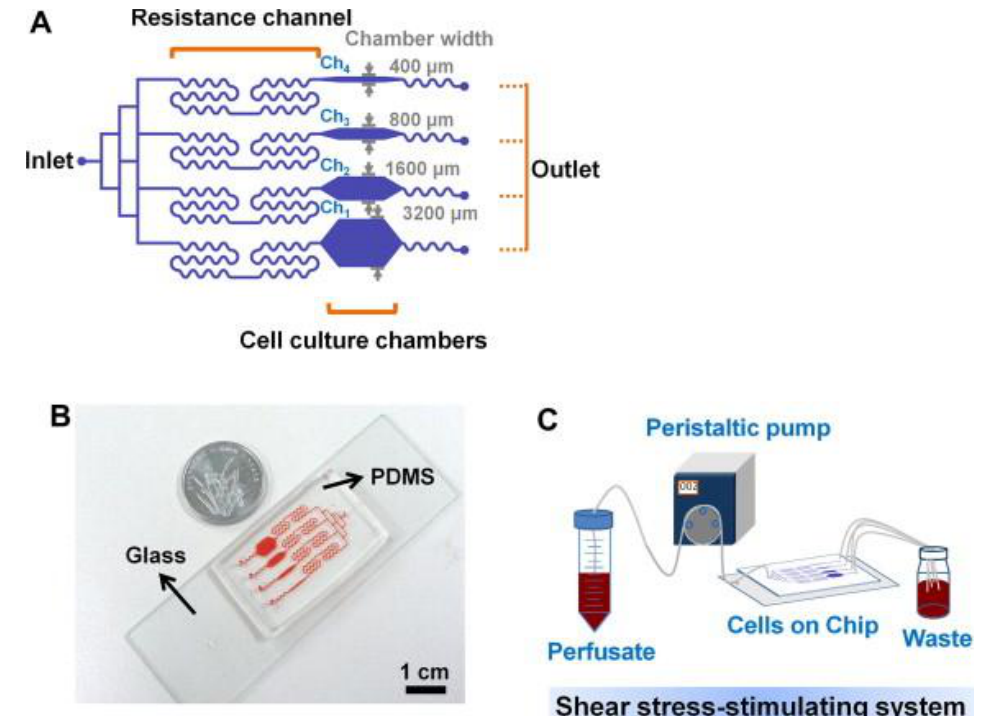
Figure 3. Multishear microfluidic device used for assessing bone cell response to fluid flow at varying shear stresses. ( A ) Flow path in microfluidic chip with resistance channels. The channel with narrow chamber width (e.g., 400 (cid:541) m) produced higher shear stress. ( B ) Size comparison of chip with a coin. ( C ) System overview of media flow path. Reprinted with permission from Elsevier (Kou et al.